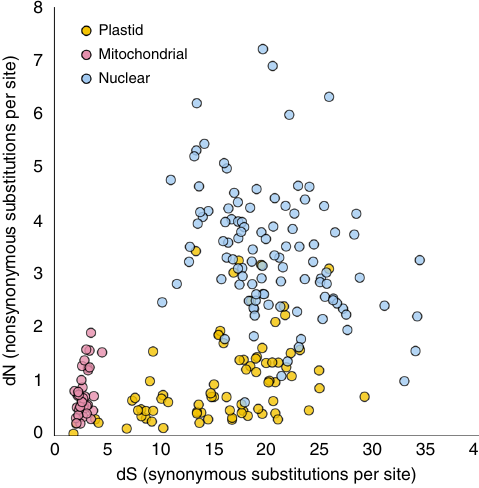
Fig. 2 Total gene tree depth in synonymous (dS) and non-synonymous (dN) substitutions per site for protein-coding genes in three genomic compartments across Bryophyta. Units are synonymous (dS) or non- synonymous (dN) substitutions per site. Rates were calculated using individual gene trees in PAML with the liverwort outgroups removed. Rates for individual genes can be accessed in the online version of the fi gure